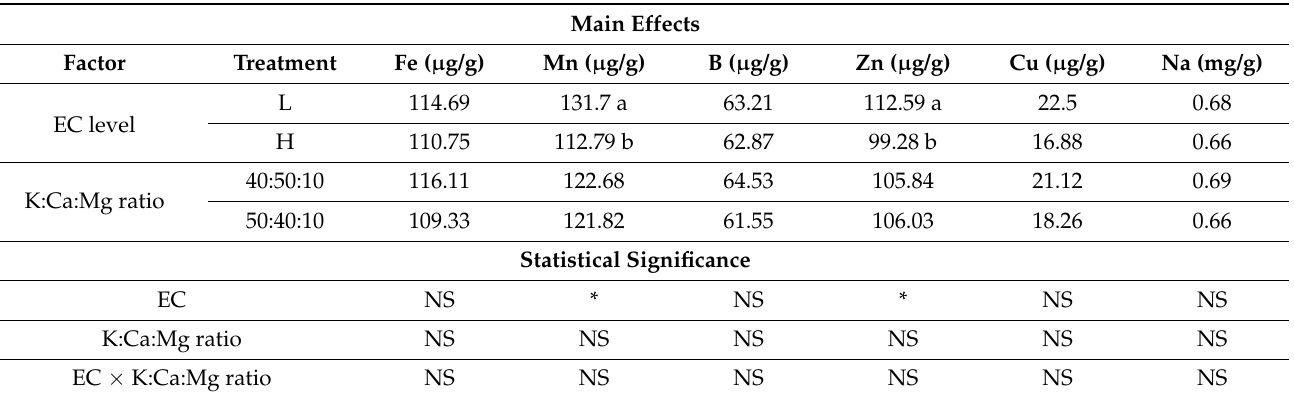
Table 4. Impact of different EC levels (low and high, as L and H, respectively) and K:Ca:Mg ratios (40:50:10 and 50:40:10) on the concentration of micronutrients (Fe, Mn, B, Zn, Cu, Na) in leaf tissues of hydroponically grown spiny chicory.